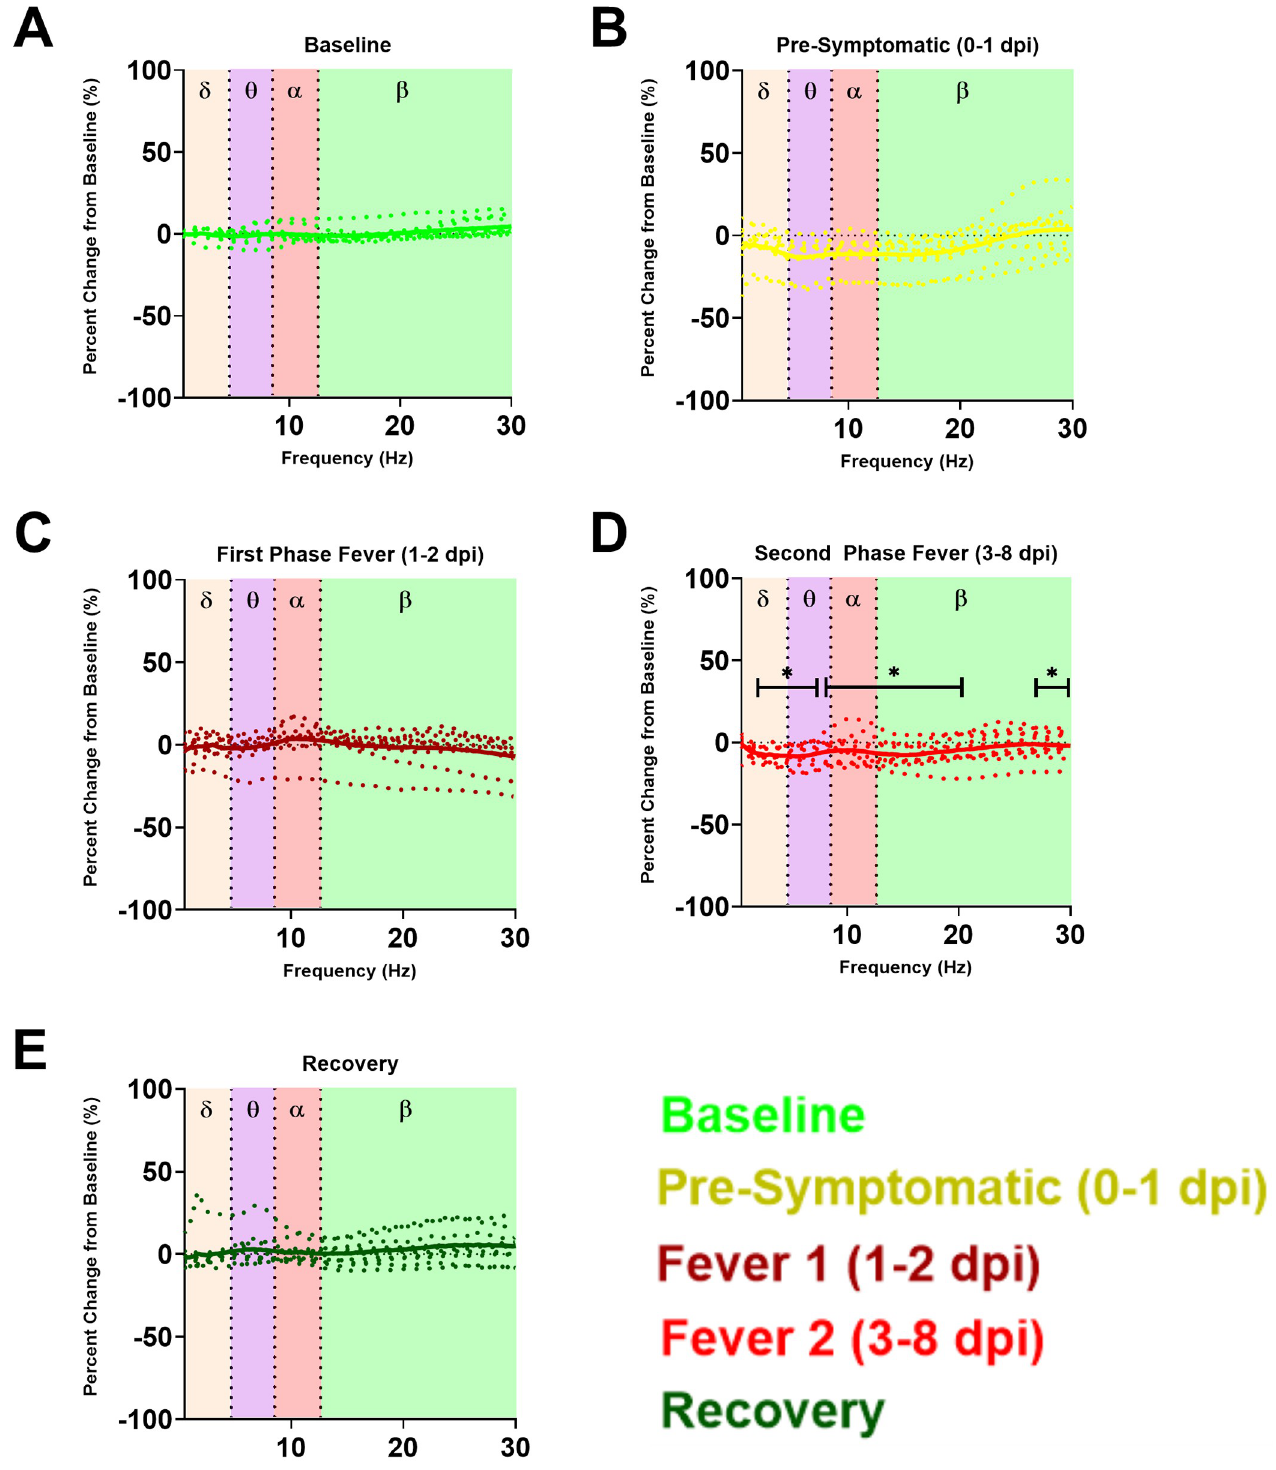
Fig 4. EEG power spectral density plot magnitude as percentage change from baseline in VEE. Power spectral density plotted as percent change from A) baseline in cohorts of VEEV-infected macaques from B) pre-symptomatic, C) first phase fever, D) second phase fever, and E) recovery. Solid traces indicate group average percentage change while dotted traces illustrate percentage change in individual macaques. Wave bands are color coded by shaded boxes; the